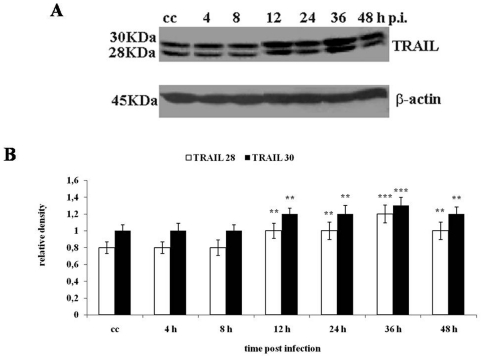
CCoV-II infection modulates TRAIL protein expression.(A) Cell lysates were collected at the indicated times p.i., and equal amounts of proteins from each sample were subjected to Western blot analysis and probed for TRAIL antibody which recognized the 28–30 KDa bands for TRAIL-R1 and TRAIL-R2, respectively. β-actin was used as a loading control. The molecular weight (KDa) of protein size standards is shown on the left hand side. Blot is representative of three separate experiments. (B) Densitometric analysis of blots relative to TRAIL 30 and TRAIL 28. The bars represent the mean ± SEM of the results from three separate experiments. Significant differences between CCoV-II-infected cells and control cells are indicated by probability P. **P <0.01, and ***P <0.001.